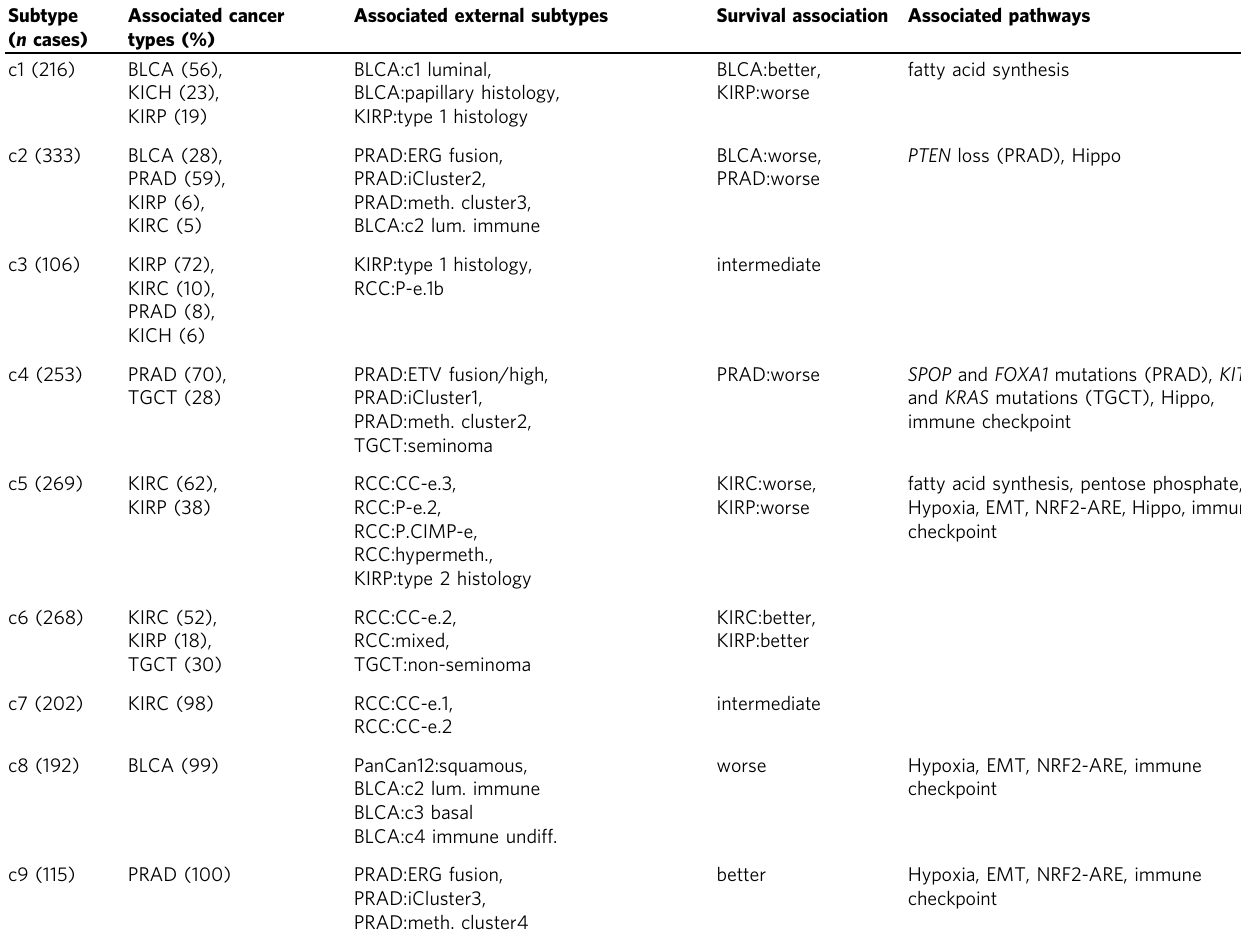
Table 1 Pan-urologic cancer genomic subtypes Subtype ( n